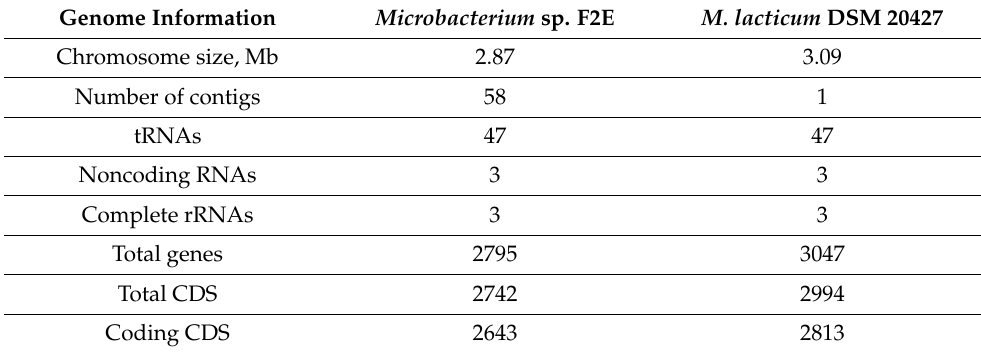
Table 3. Genomic features of M. lacticum DSM 20427 and Microbacterium sp.